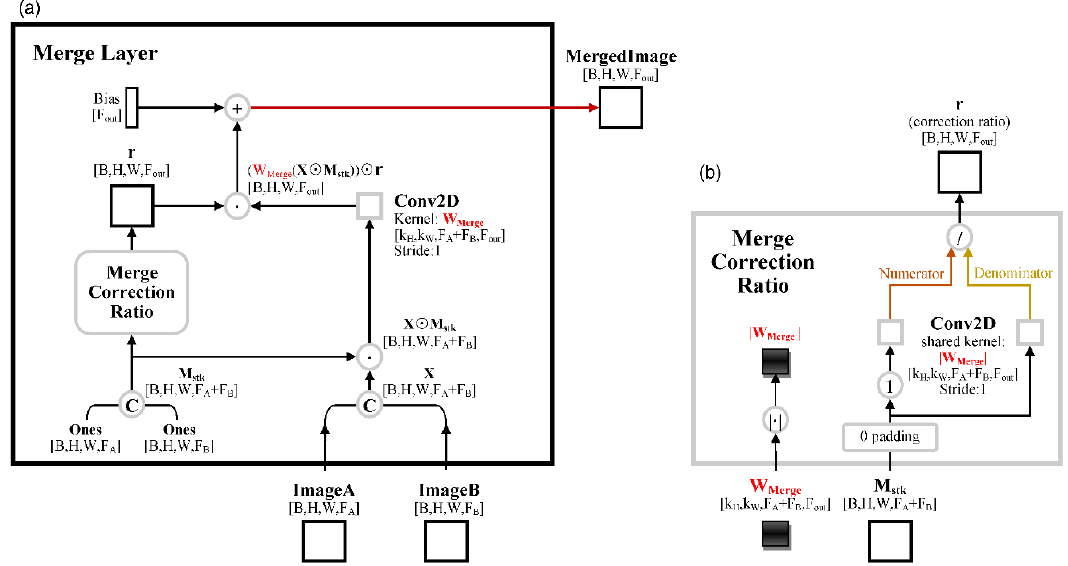
Figure 6. The flowchart of a SAPC2 Merge layer (Merge) ( a ); and the Merge Correction Ratio submodule ( b